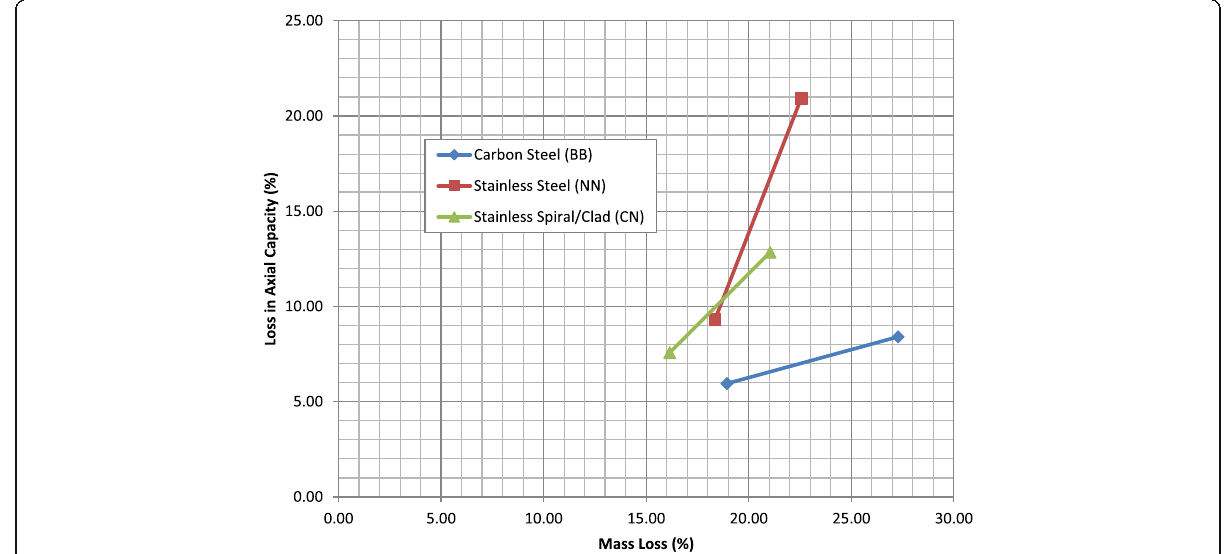
Fig. 16 Axial compression capacity loss in term of mass